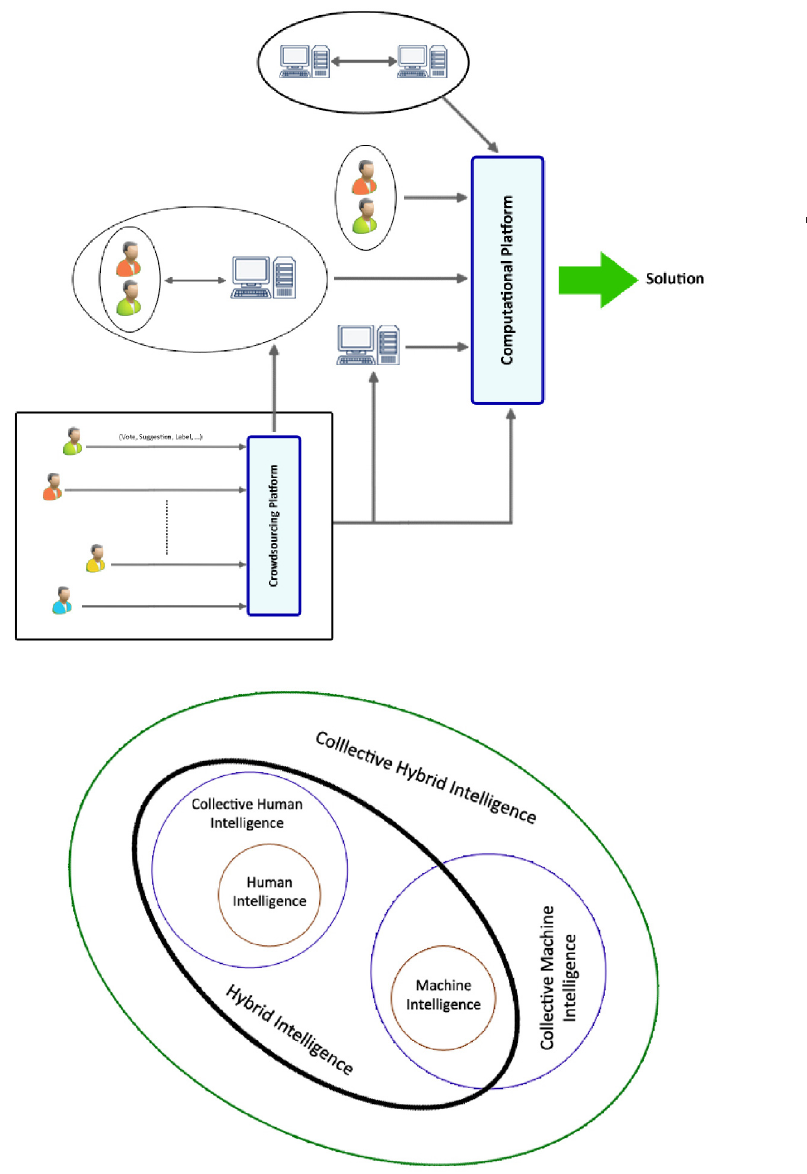
Figure 5. Relationships between CHI and related concepts